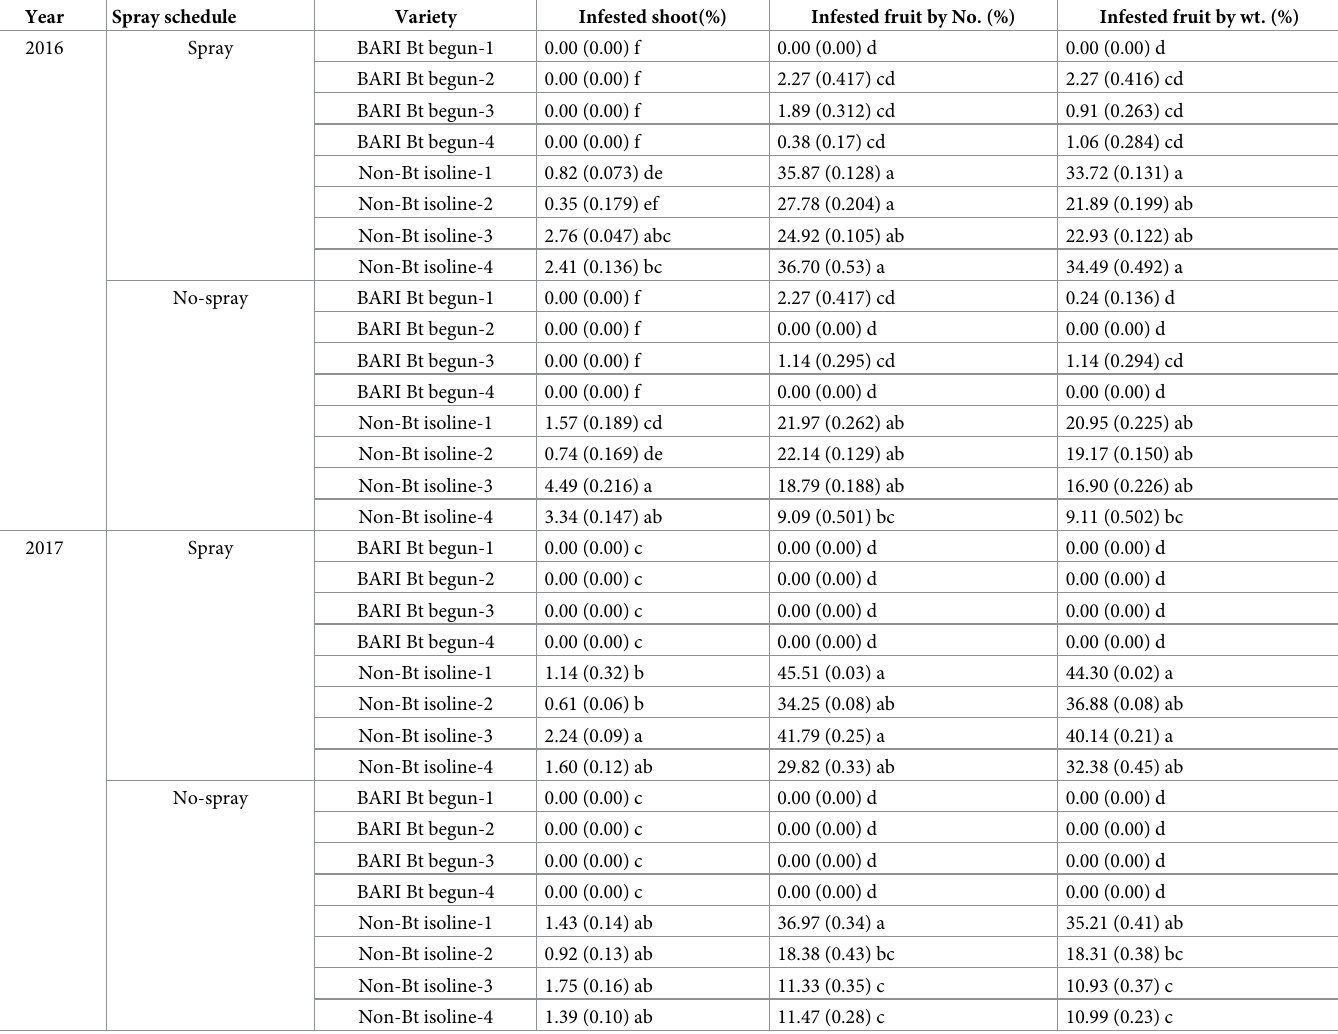
Table 1. Mean infestation 1 in brinjal by brinjal shoot and fruit borer (BFSB) relative to insecticides regimes and variety, OFRD, BARI, Bogra,